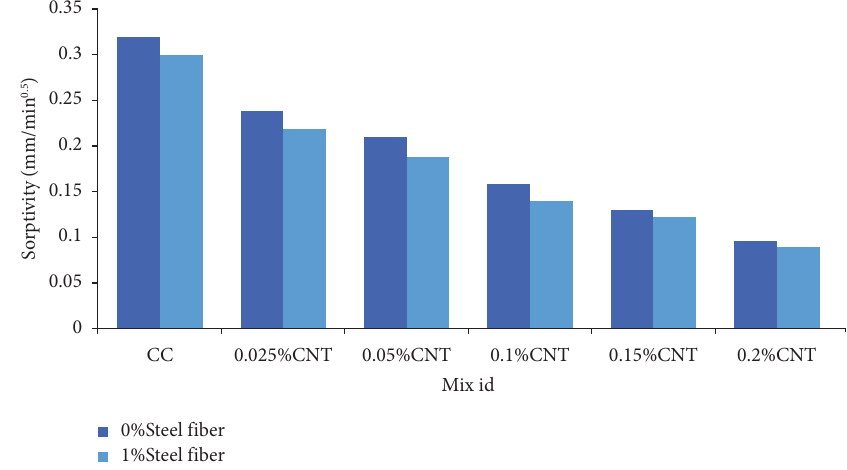
Figure 15: Sorptivity results (specimens subjected to primary sorption).